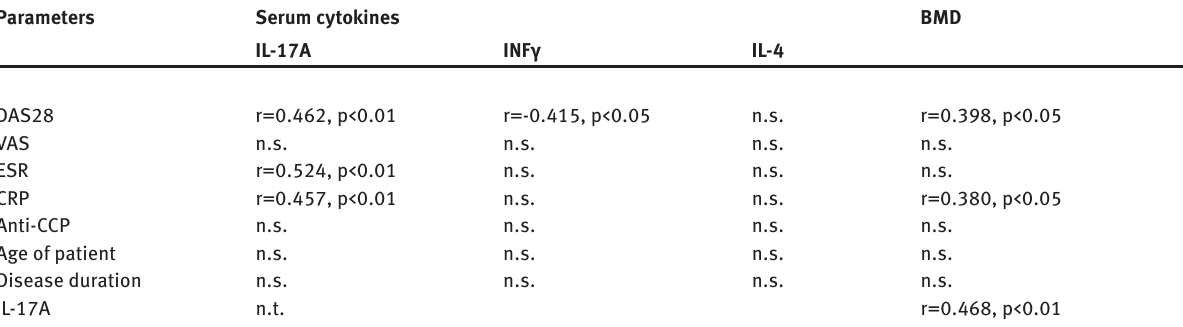
Table 3. Correlations of serum cytokine concentrations and BMD with clinical and diagnostic parameters of patients with early RA Parameters